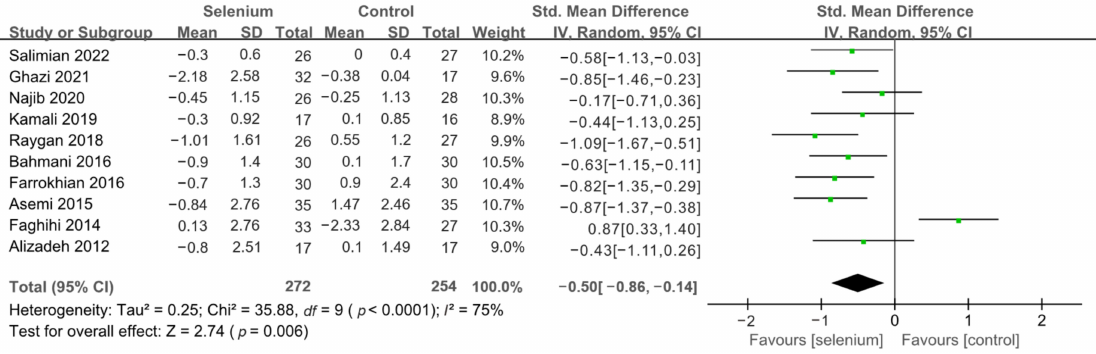
Figure 5. Forest plot of HOMA-IR